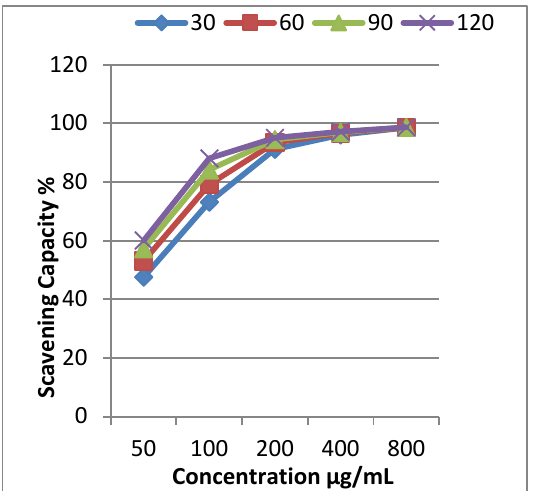
Figure 1. Free-radical-scavenging activity of clove essential oil and IC 50 values for scavenging 50% of the free radicals DPPH (IC 50 = 50 µg/mL).